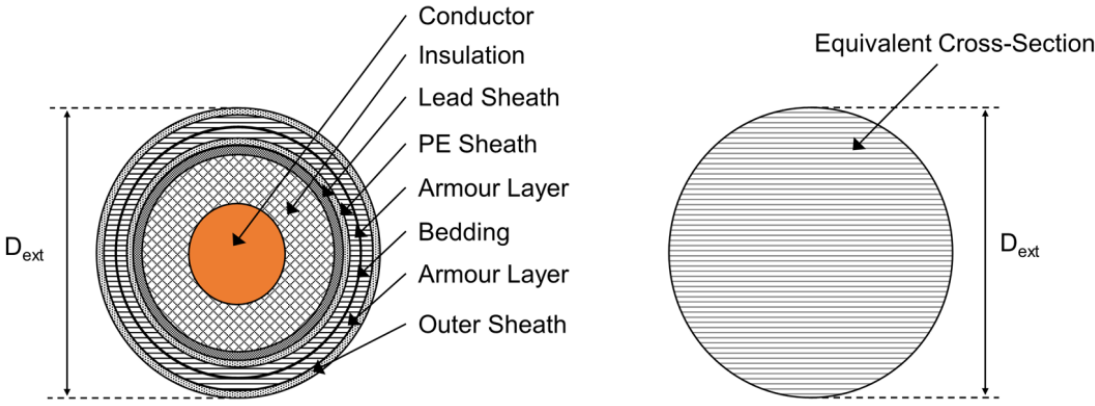
Figure 5. Submarine power cable and its equivalent cross-section.